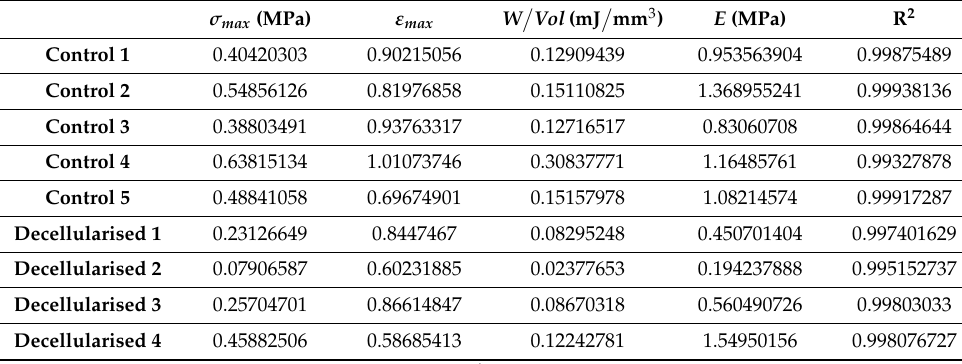
Table A1. Tensile test of control and decellularised